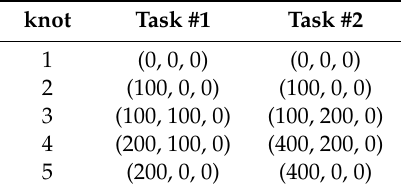
Table 1. Position (X, Y, Z) in mm of knots.